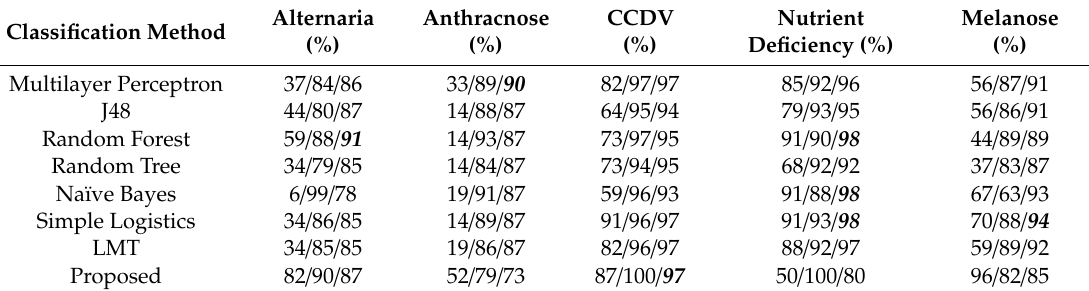
Table 5. Sensitivity / specificity / accuracy of the classification methods listed in the 1 st column, using the features presented in Table 1 (group AB). The classification method with the best accuracy for each disease is highlighted with bold-italics.